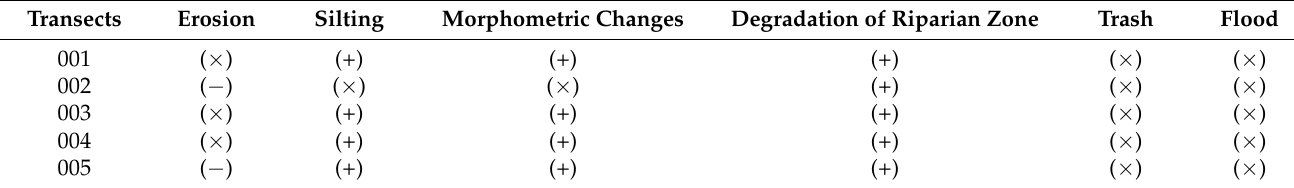
Table 10. Summary table of the problems detected in the River